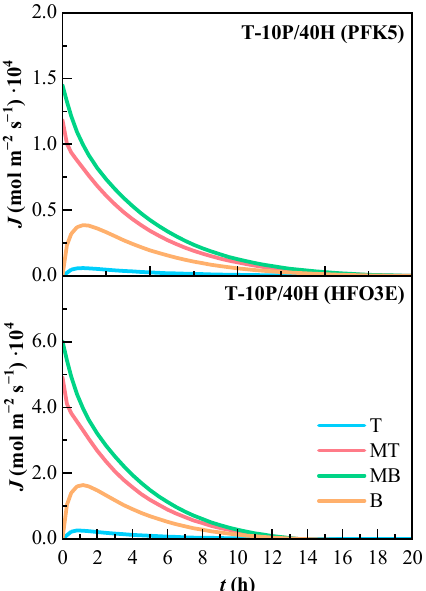
Figure 9. Variation of the estimated molar flux ( J ) of the components of the ternary mixture over time. T (Top), MT (Medium Top), MB (Medium Bottom), and B (Bottom) correspond to the different heights of the measurement lines.